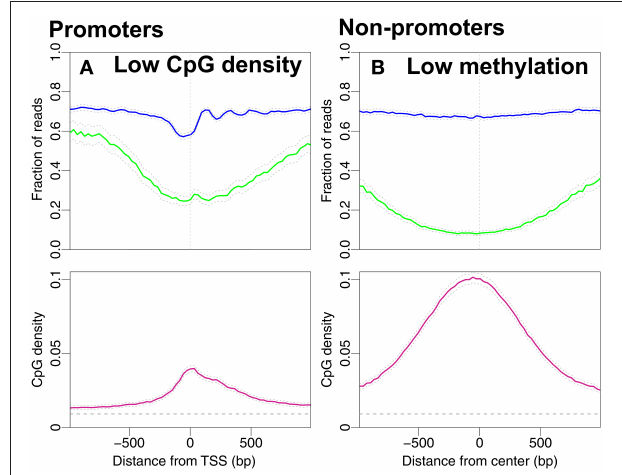
FIGURE 3 | Nucleosome occupancy (blue), methylation level (green) and CpG density (pink). (A) Promoters with low CpG densities, resembling the density profile in Figure 2C . 8,215 promoters with average CpG density lower than the average CpG density among all 18,015 promoters in Figure 1A ( ≈ 0.04). (B) Regions with low methylation levels are chosen from the non-promoter regions in Figure 1B . 7,367 regions with average methylation lower than the average methylation level of all non-promoter regions in Figure 1B ( ≈ 0.39). The gray dashed line indicates the average CpG density (0.009) in the genome.